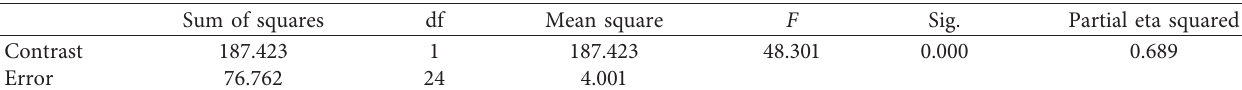
Table 5: Univariate tests.